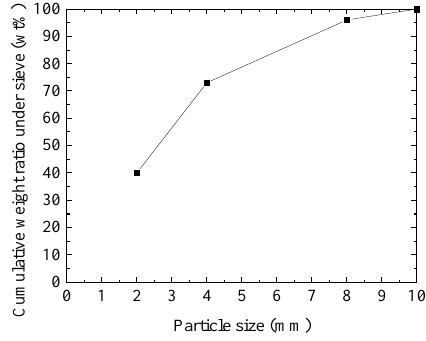
Figure 1. Particle size distribution of sinter feed.